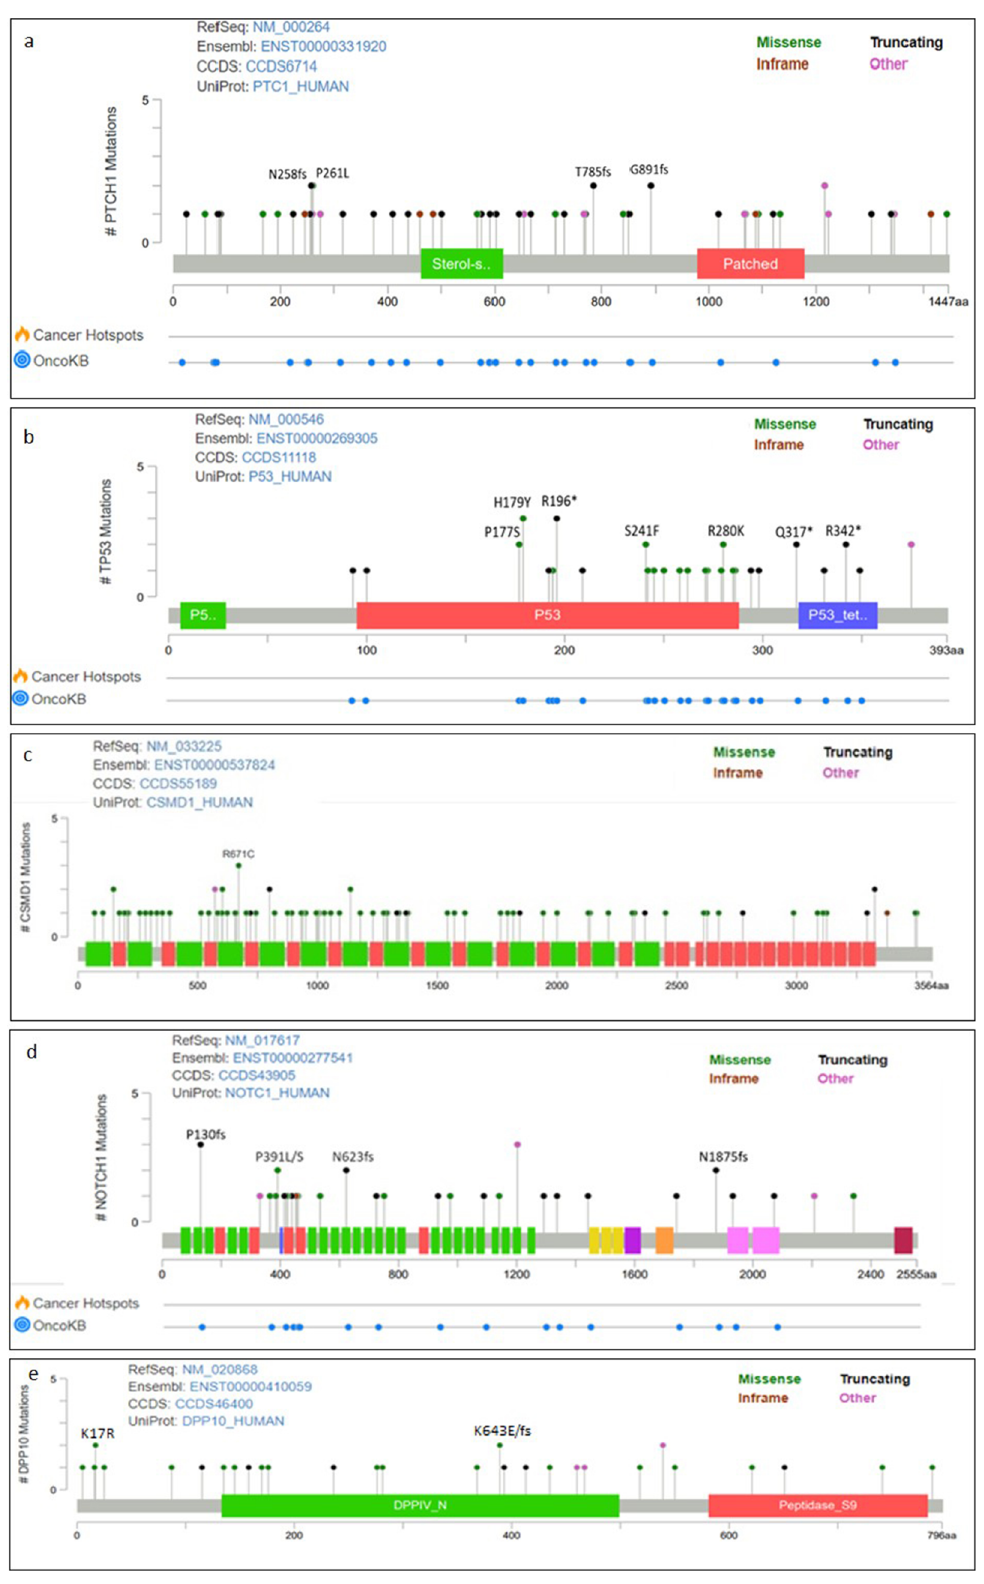
Figure 2. Mutational profiles interpreted with protein annotation. The protein figure was generated with MutationMapper in cBioPortal tool. Alterations occurring two and/or more times are specified in the protein domains. ( a ) PTCH1 : the sterol- sensitive and Patched family functional protein domains are represented by green and red boxes, respectively. ( b ) TP53 : the transactivation, DNA-binding and tetramerization domains are represented by green, red and blue boxes, respectively. ( c ) CSMD1 : the CUB and SUSHI domains are represented by green and red boxes, respectively. ( d ) NOTCH1 : the EGF-like domains are represented by green boxes. ( e ) DPP10 : the dipeptidyl peptidase N-terminal domain is represented by green